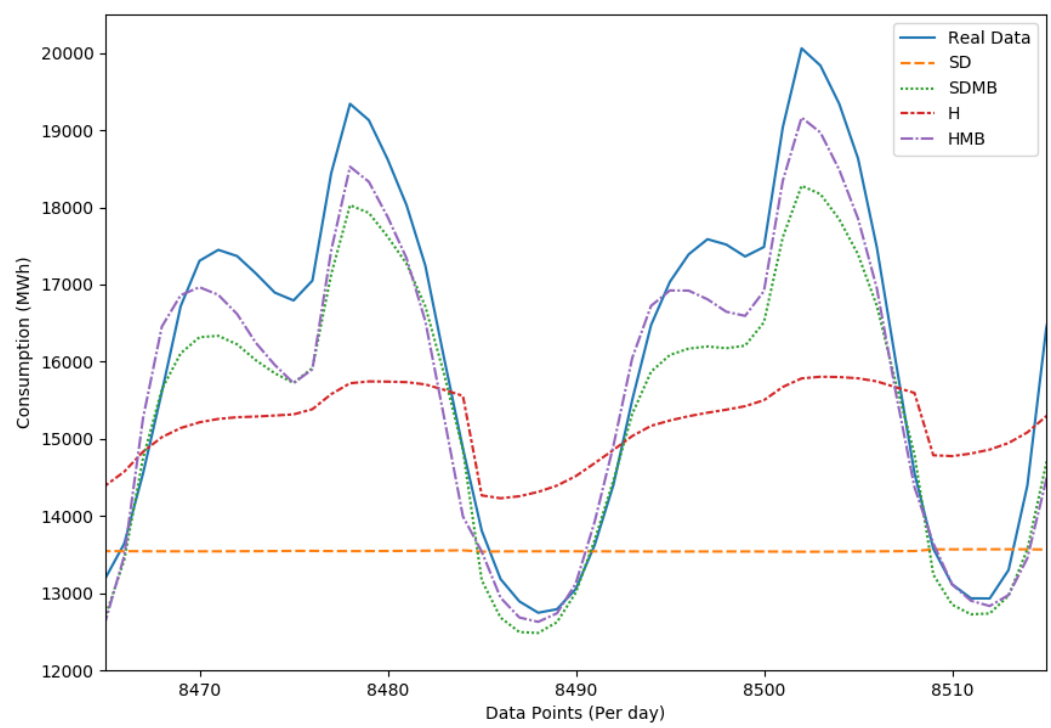
Figure 6. A zoom of the neural network with the algorithms during testing.